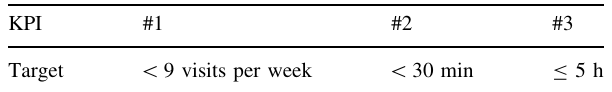
Table 2 Target for each